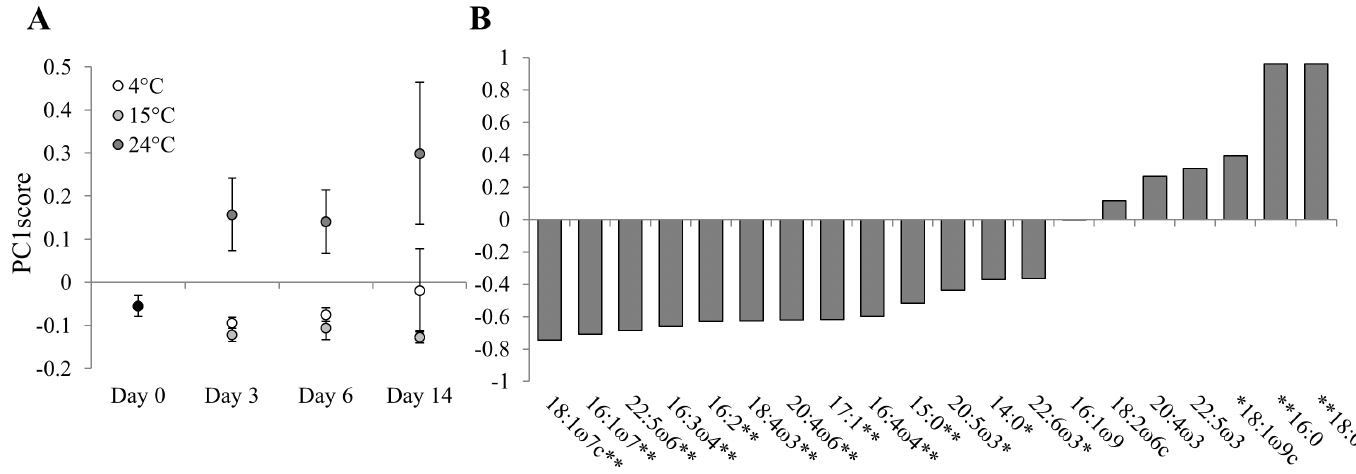
Fig 3. Storage FA composition of the copepod P . littoralis prior (day 0) and after 3, 6 and 14 days of food deprivation at different temperatures (4, 15 and 24°C). (A) The PC1score values ( ± SD) for storage lipids are displayed with (B) the Spearman ’ s rho correlation coefficients of individual FAs (%) used for the PCA with the correlation significance levels ( * p < 0.05; ** p <